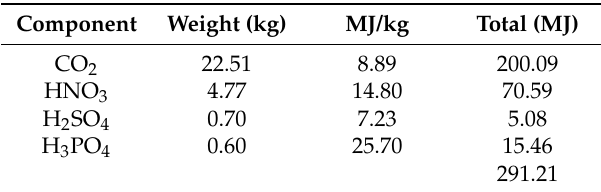
Table 3. Nutrients’ energy demand.